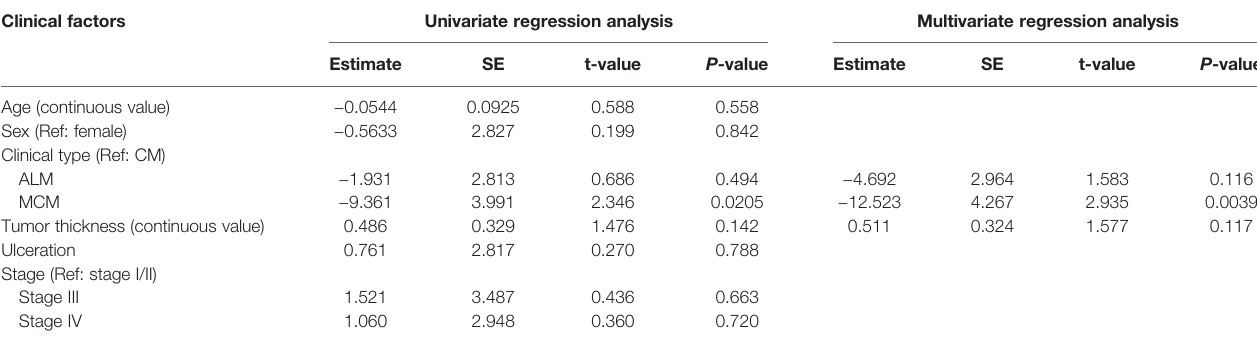
TABLE 3 | Association of CD4 + TIL number with clinical factors. Clinical